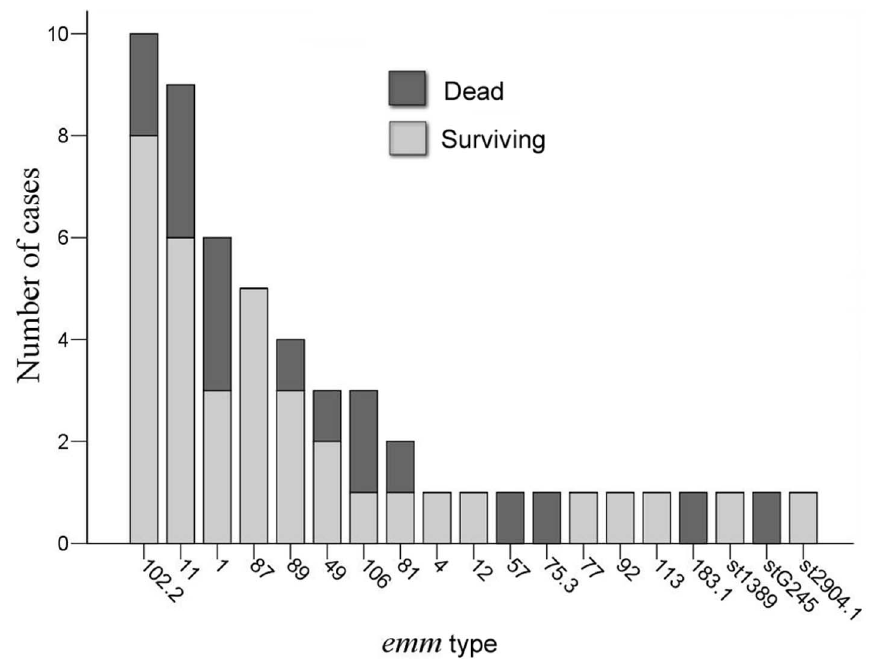
Figure 2. The distribution of emm types in Streptococcuspyogenes and fatality in patients with streptococcal toxic shock syndrome. A total of 19 different emm types were identified. The most prevalent emm type was emm 102 (18.9%), followed by emm 11 (17%), emm 1 (11.3%), emm 87 (9.4%), and emm 89 (7.5%). Patients infected with GAS emm 1 (50%) and emm 106 (66.7%) had a higher mortality rate, while patients infected with emm 102 had a lower fatality rate of 20%.